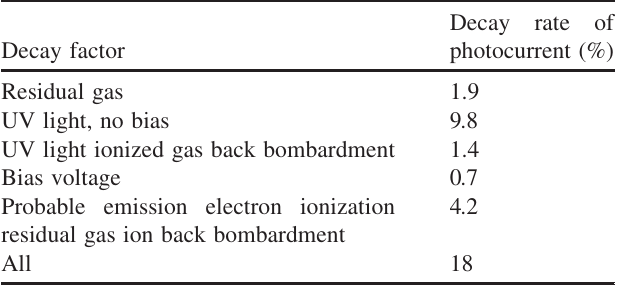
TABLE I. Different causes of photocurrent decay.